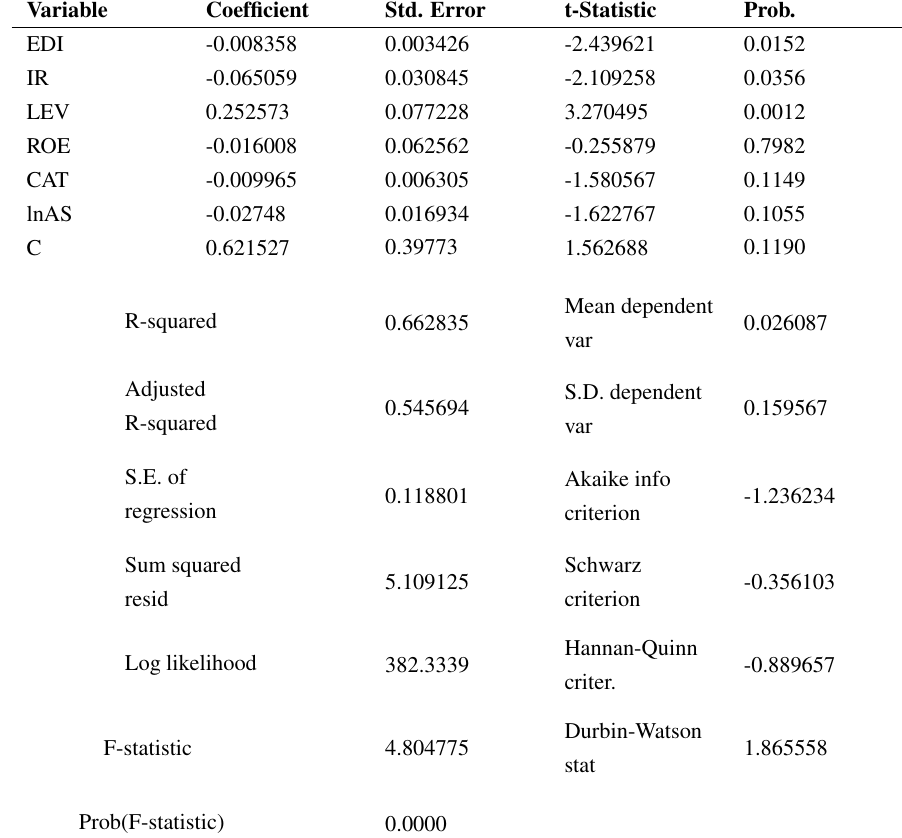
Table 7 Individual fixed effect model of second models